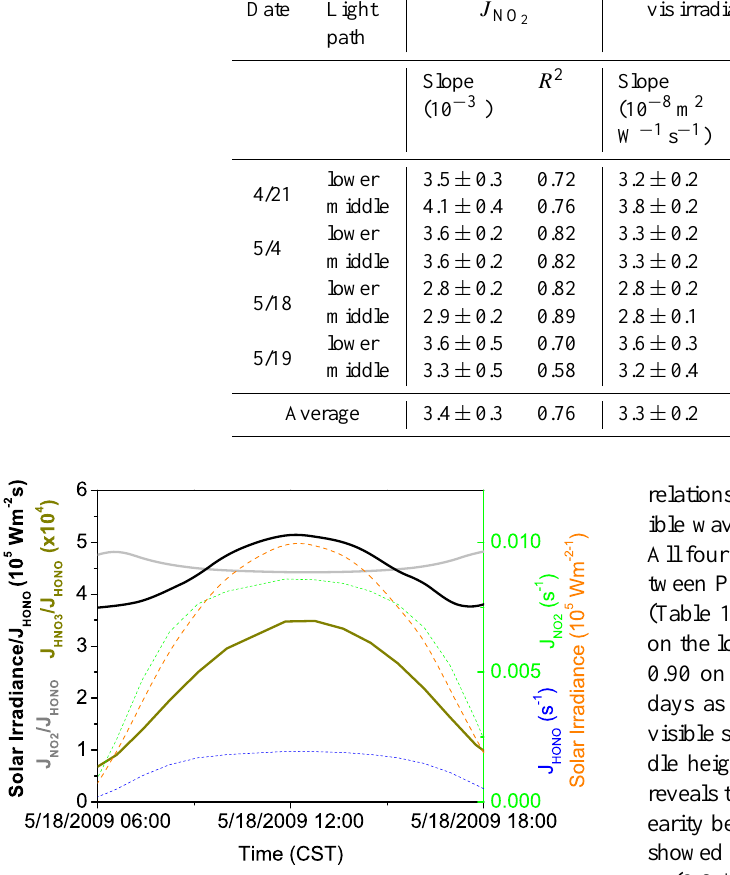
, J HONO and the ratios 2 , J HNO 3 / J HONO and J NO / J HONO on 18 2 2